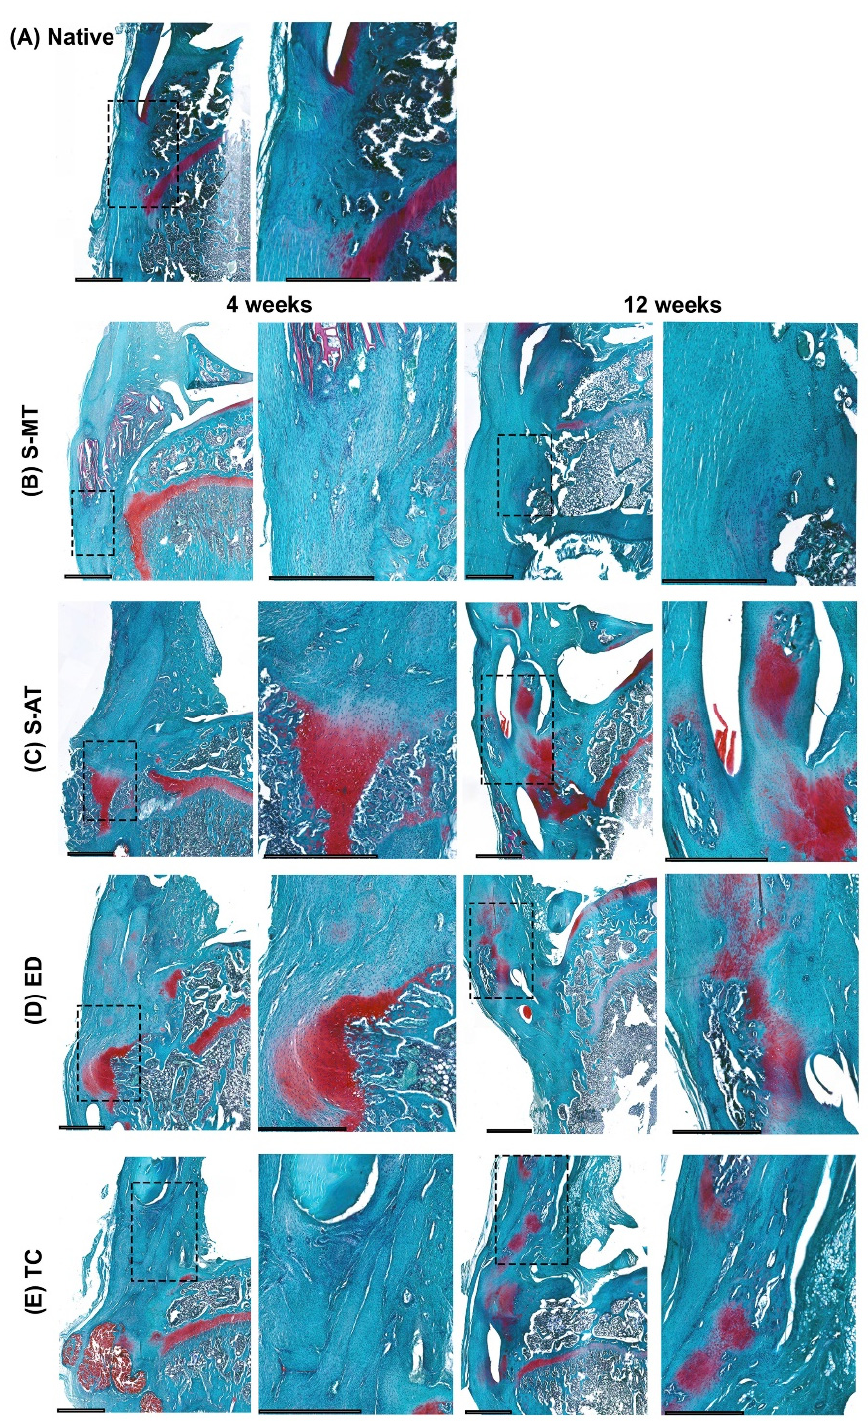
Figure 5. Safranin O staining. Representative images of the histological analysis of enthesis defects at the patellar region at 4 (left pairs) and 12 weeks (right pairs) after surgery, in ( A ) native enthesis, ( B ) S-MT with mixed transition, ( C ) S-AT with abrupt transition, ( D ) empty defect, and ( E ) transversal cut at enthesis site. Proteoglycan-rich cartilage appears red (here the orange to red color indicates endochondral ossification), and background appears blue. Dashed squares in the left pairs indicate the locations of the zoomed-in areas shown on the respective right. Scale bars = 800 µm.